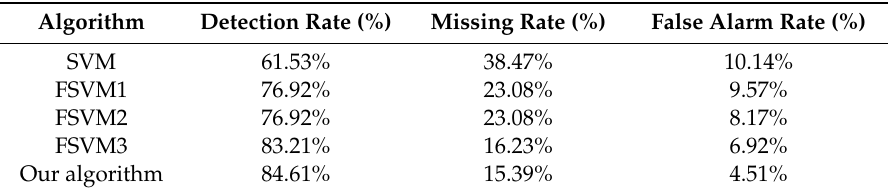
Table 2. Performance comparison on data set UNM_sendmail.